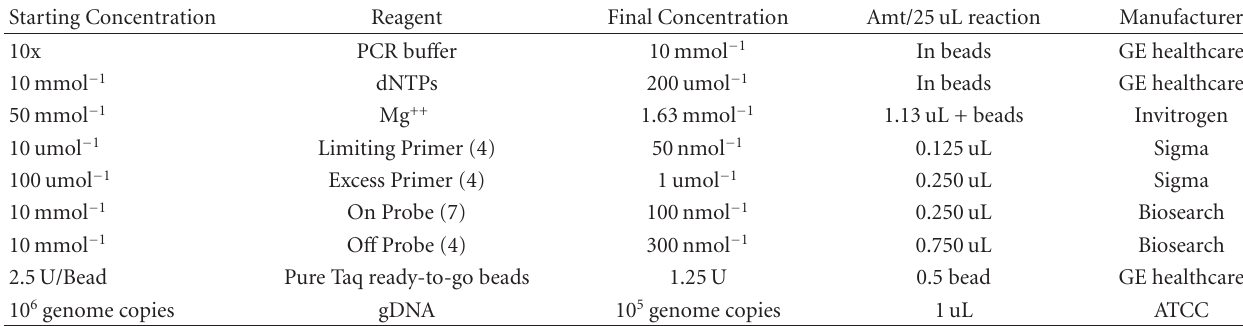
Table 5: LATE-PCR 16S sepsis multiplex